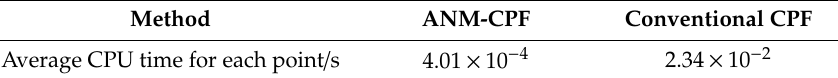
Table 1. Calculation time of one point in PV curve for both methods.